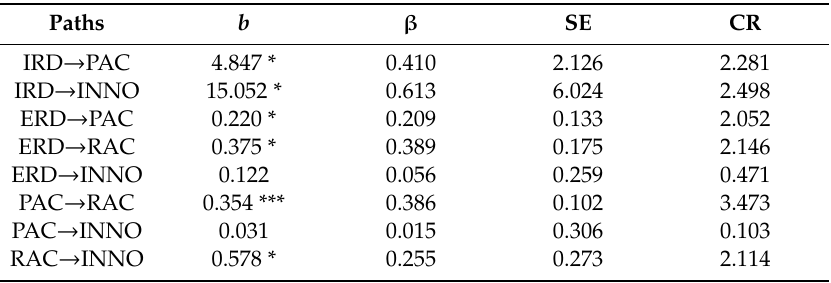
Table 7. Direct e ff ects in the model.